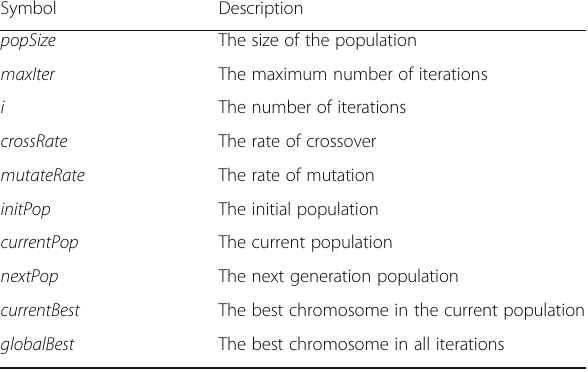
Table 2 The parameters of